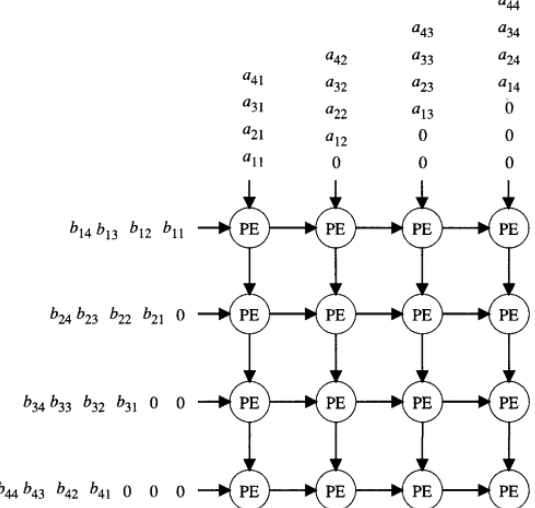
Figure 4. Matrix multiplication in the systolic array [31]. 1999 Academic Press, with permission from Elsevier.